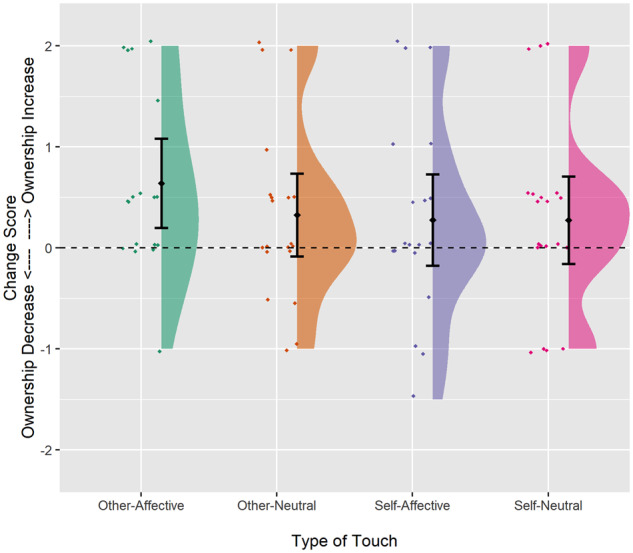

Raincloud plot illustrating change in body (dis)ownership after touch. Zero (dashed black line) indicates no change in (dis)ownership. Positive values indicate increased ownership/reduced DSO, and negative values indicate poorer ownership/increased DSO post-touch. The ‘cloud’ illustrates overall data distribution. Individual raw data are represented by the ‘rain’, with randomised jitter to improve visibility. Mean (black diamond) and 95% confidence interval (error bars) shown.